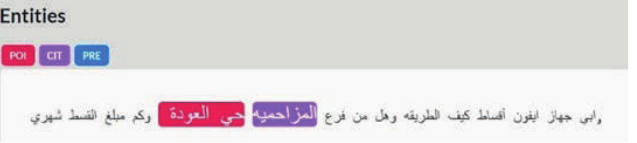
Fig. 3. Example of the testing dataset from STC